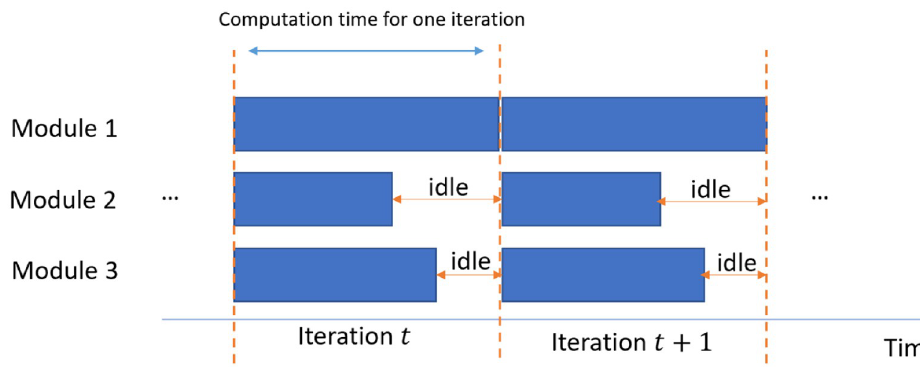
Fig 4. Example of module imbalance.